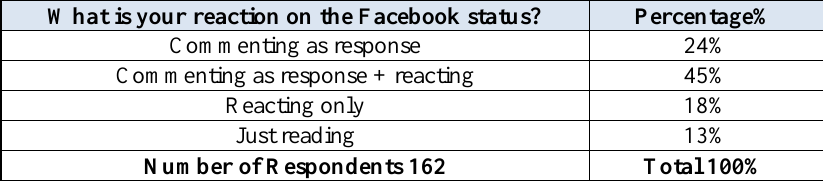
Table 2. Reading & Response on Facebook